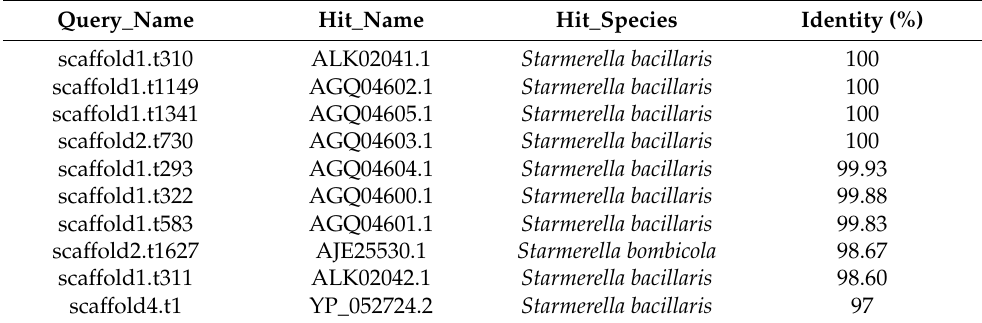
Table 1. Sequence identity statistics of the S. bacillaris CC-PT4 genome annotated in NCBI nr (top 10).